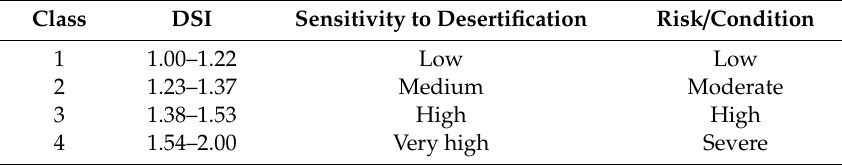
Table 3. Ranges and classes of desertification sensitivity